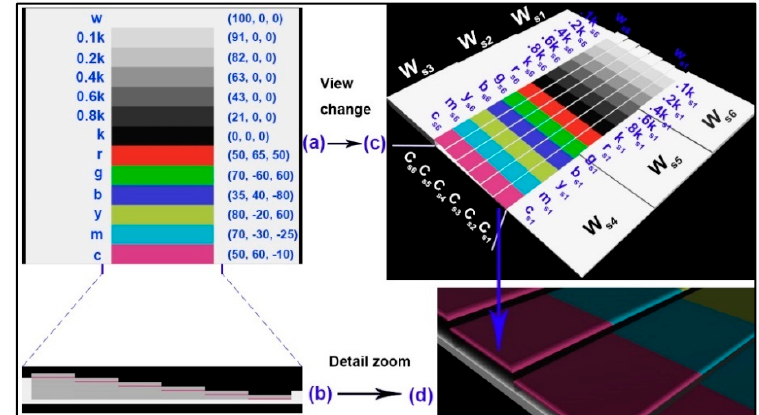
Figure 7. A three-dimensional (3D) color test chart: ( a ) top view; ( b ) local side view; ( c ) global view with relative marks; ( d ) local details of stairs.